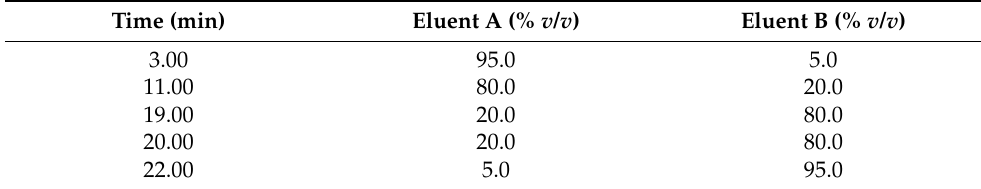
Table 4. HPLC gradient for quantification of bisoprolol